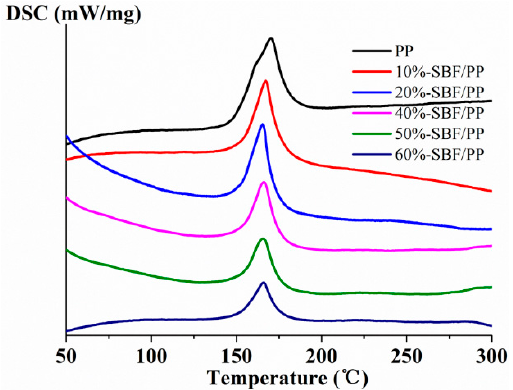
Figure 10. Di ff erential scanning calorimetry (DSC) curves of PP and the composites with di ff erent Figure 10. Differential scanning calorimetry (DSC) curves of PP and the composites with different SBF SBF contents. Table 2. Thermal properties of PP, SBFs, and the composites.